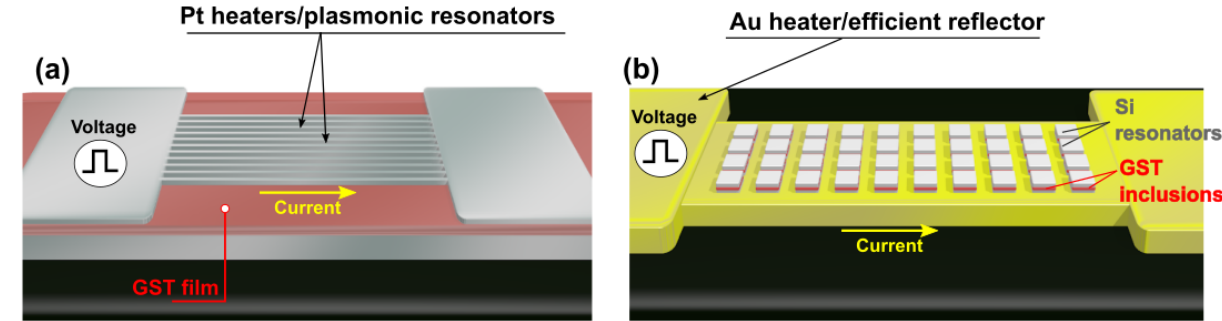
Figure 1. ( a ) Schematics of electrical switching of reconfigurable phase-change plasmonic metasurfaces where Pt resonators are simultaneously used as resistive heaters, (as described in [24]). ( b ) Concept of electrical switching of reconfigurable hybrid dielectric/plasmonic phase-change metasurfaces where highly efficient plasmonic metals (here Au) are simultaneously used as bottom heater and reflective plane.